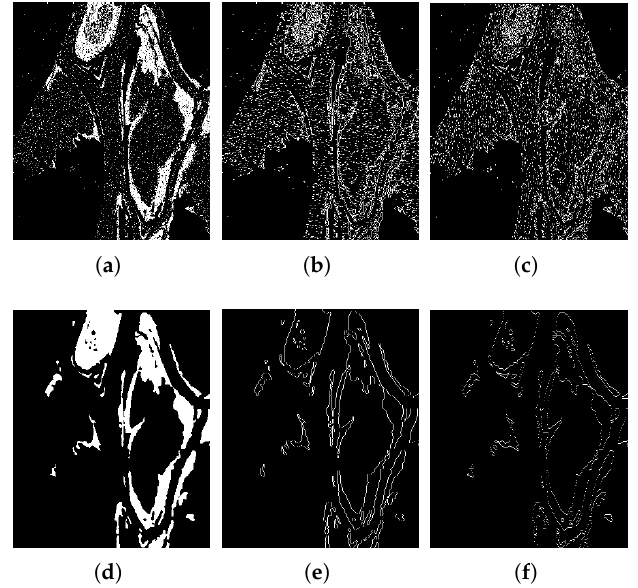
Figure 7. The thresholding results and the label of Ottawa datasets, as well as the output of the high pass filter. ( a ) The thresholding result; ( b ) The row difference image of ( a ); ( c ) The column difference image of ( a ); ( d ) label; ( e ) The column difference image of ( d ); ( f ) The row difference image of ( d